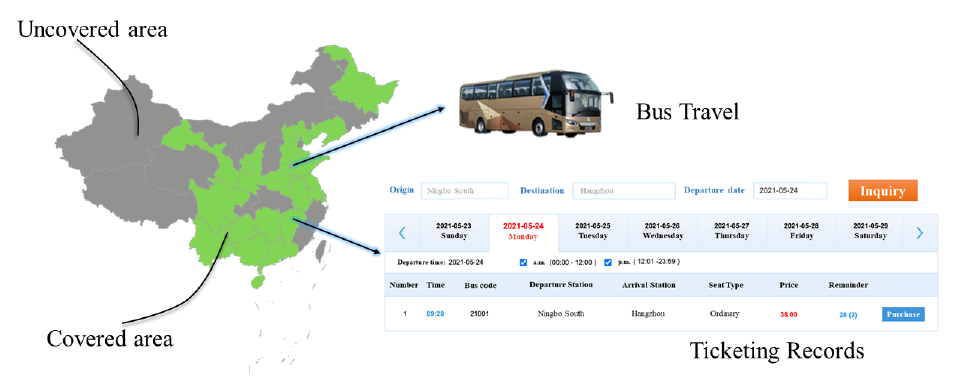
Figure 1. The bus ticketing data covered 19 provinces, including 2705 long-distance bus station’s travel records. The data range from April 2020 to August 2020. Each record describes the detailed information of a passenger’s trip, including start time, arrival time, name of the departure station, name of the terminal station, and the passenger’s gender and